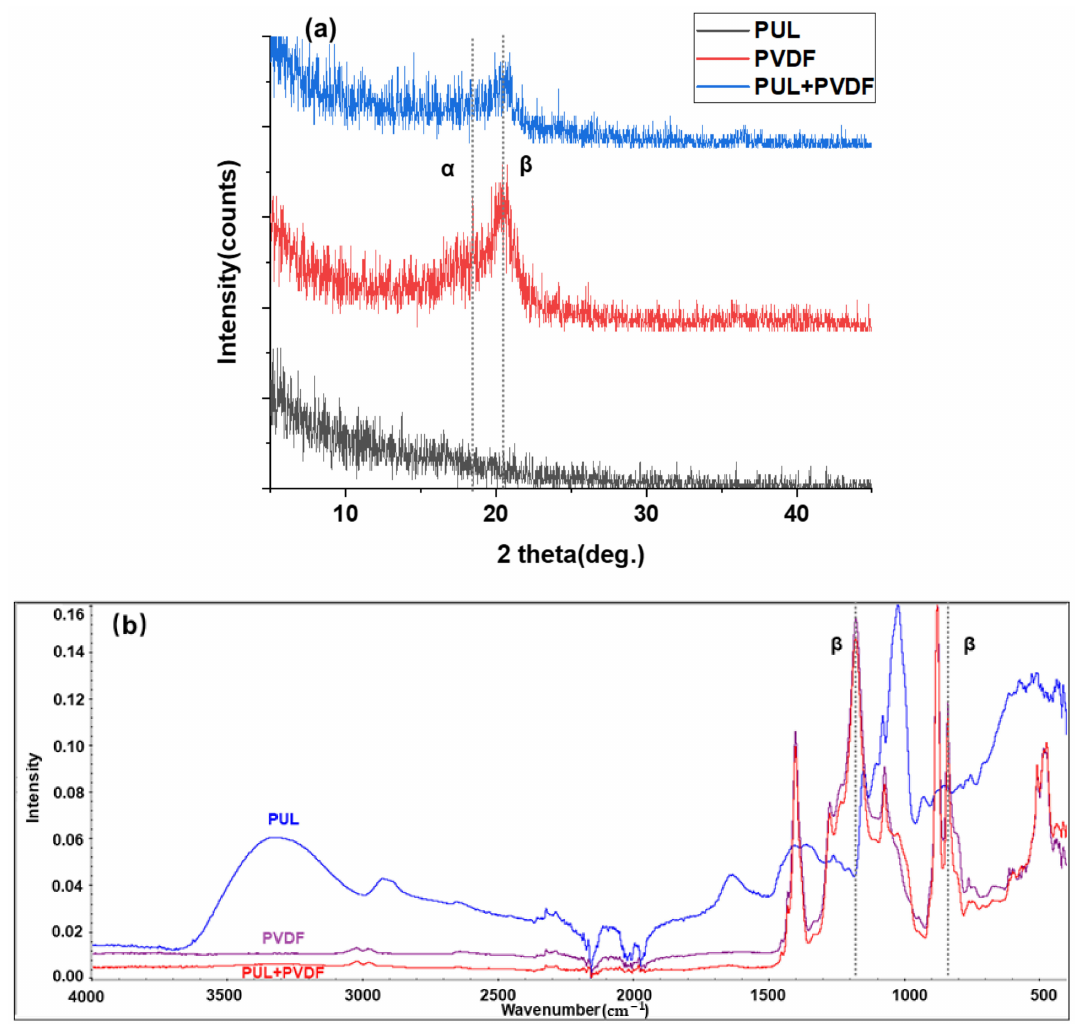
Figure 6. ( a ) XRD patterns and ( b ) FTIR spectra of the PUL, PVDF, and composite nanofiber mem-